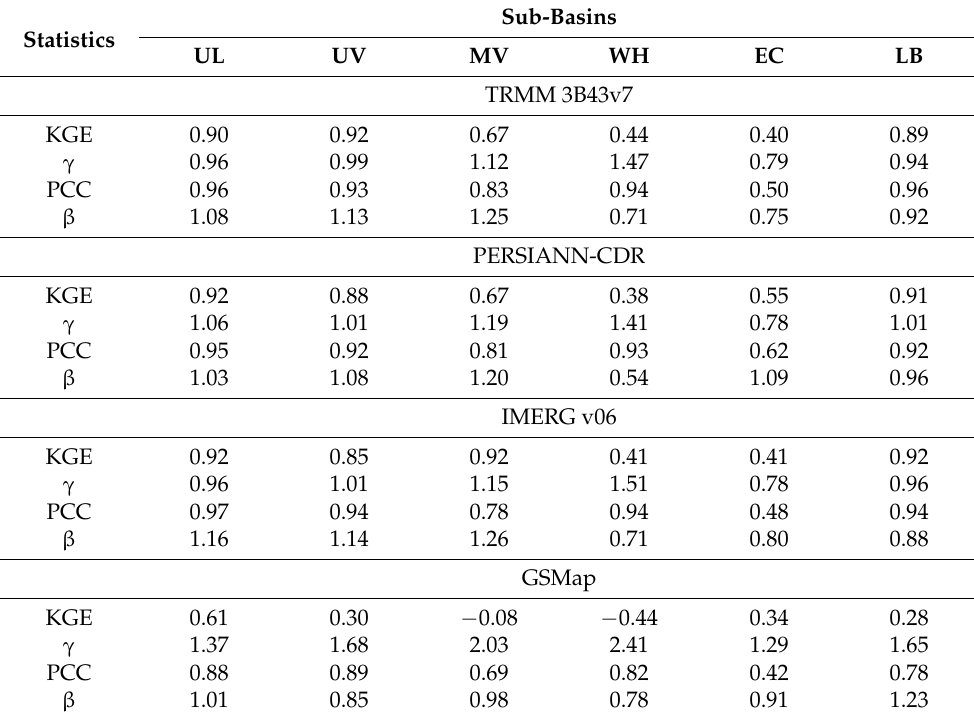
Table 4. Statistical comparison of satellite rainfall estimates (SREs) in the